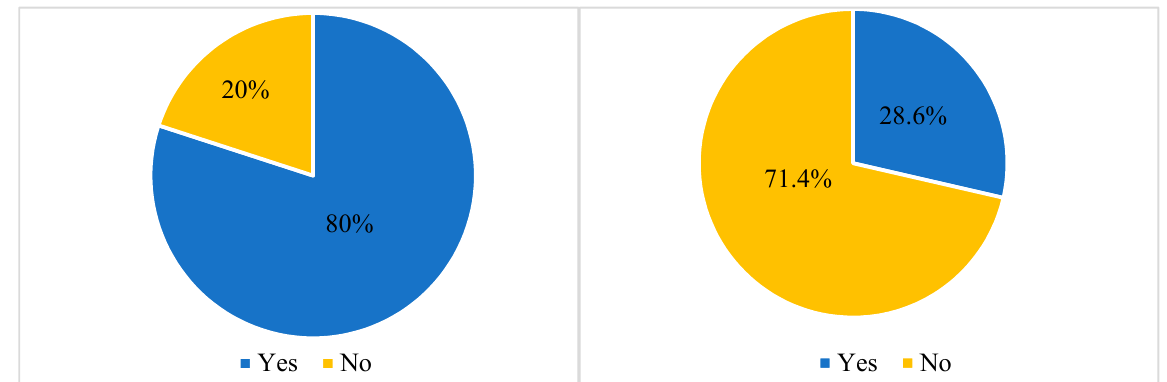
Figure 4. Assessment of the impact of the relational nature of a cooperative bank on reducing the importance of scoring models in the assessment of creditworthiness: cooperative banks using BIK scoring models ( left chart) and other cooperative banks of the BPS S.A. association ( right diagram).